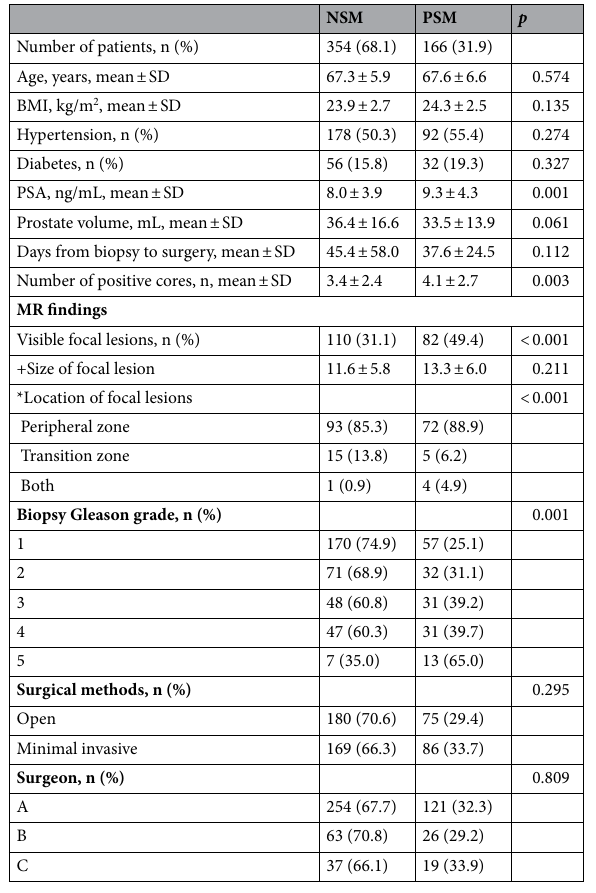
Table 1. Baseline characteristics according to surgical margin status. NSM negative surgical margin, PSM positive surgical margin. *Location of focal lesion on MR imaging was reported in 190 cases among 192 cases. +Size of focal lesion on MR imaging was reported in 86 cases among 192